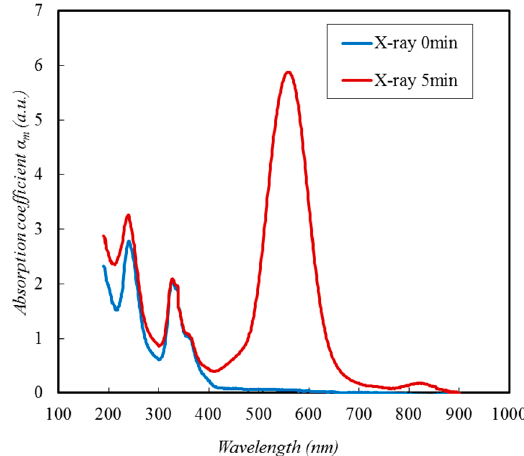
Figure 4. Absorption spectra of KCl:Eu 2+ (0.02 mol%) single crystals before and after the X-ray irradiation (irradiation time: 5 min).